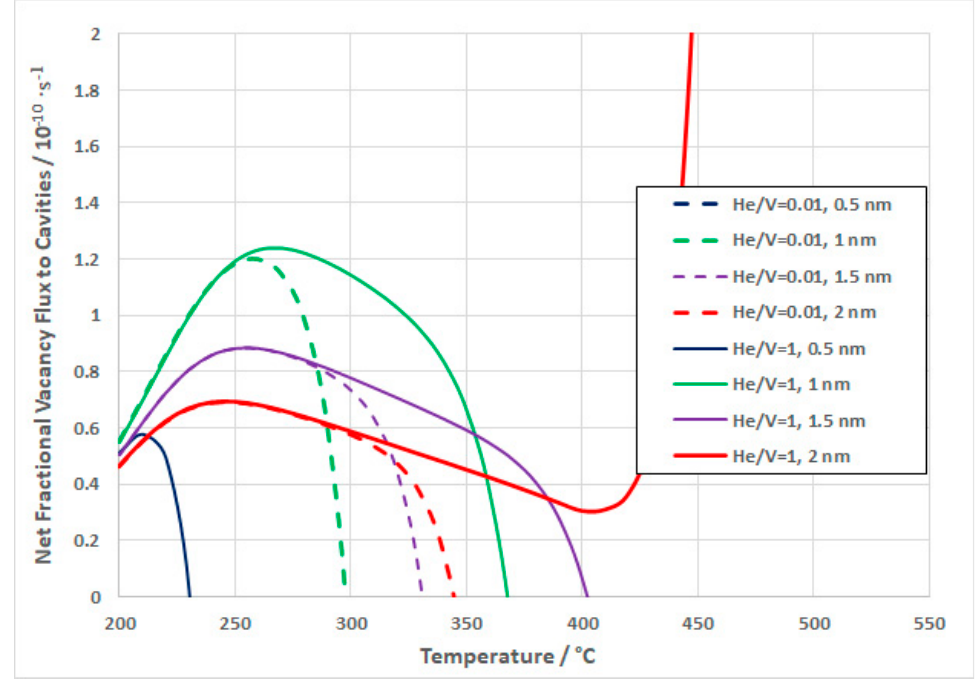
Figure 9. Rate theory output showing the vacancy flux to cavities of varying diameters as a function of temperature for Inconel X750 in a PWR or HWR (~2 DPA/year) for different cavity diameters and He/V ratios of 0.01 and